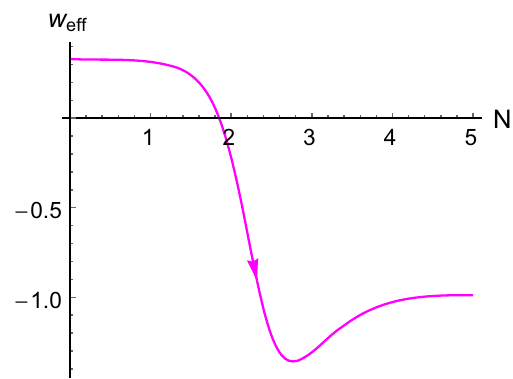
Fig. 11 The variation of the effective equation of state towards a de- Sitter cosmological epoch in the case where ξ 1 = 0 . 5 ,ξ 2 = 10 ,α 1 = 30 ,α 2 = 3 ,w m =